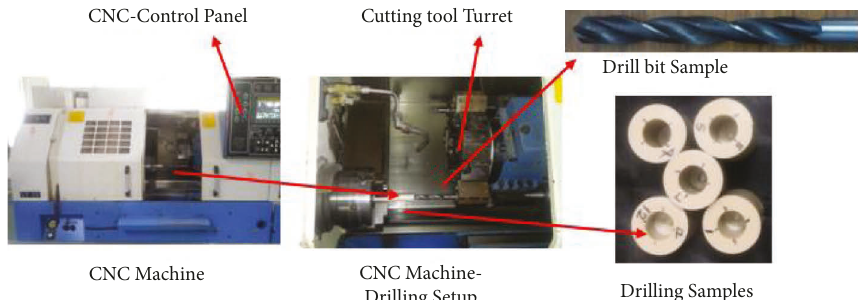
Figure 2: Experimental setup and drilled